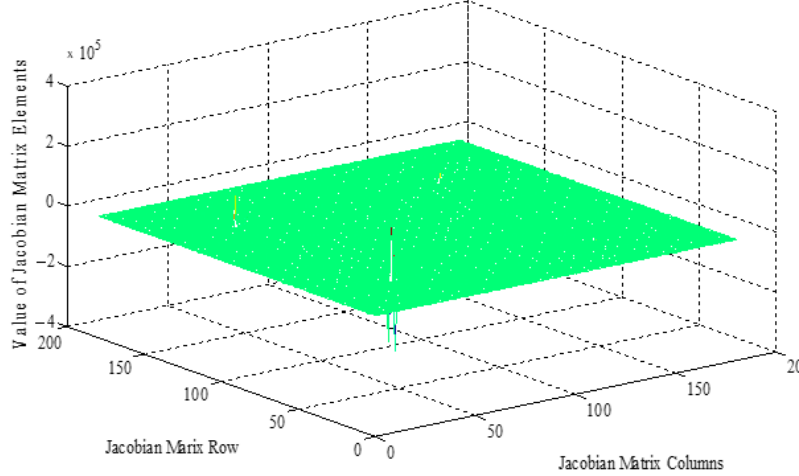
Figure 15. Solid mesh geometry of sparse Jacobian at load level of 2.775.